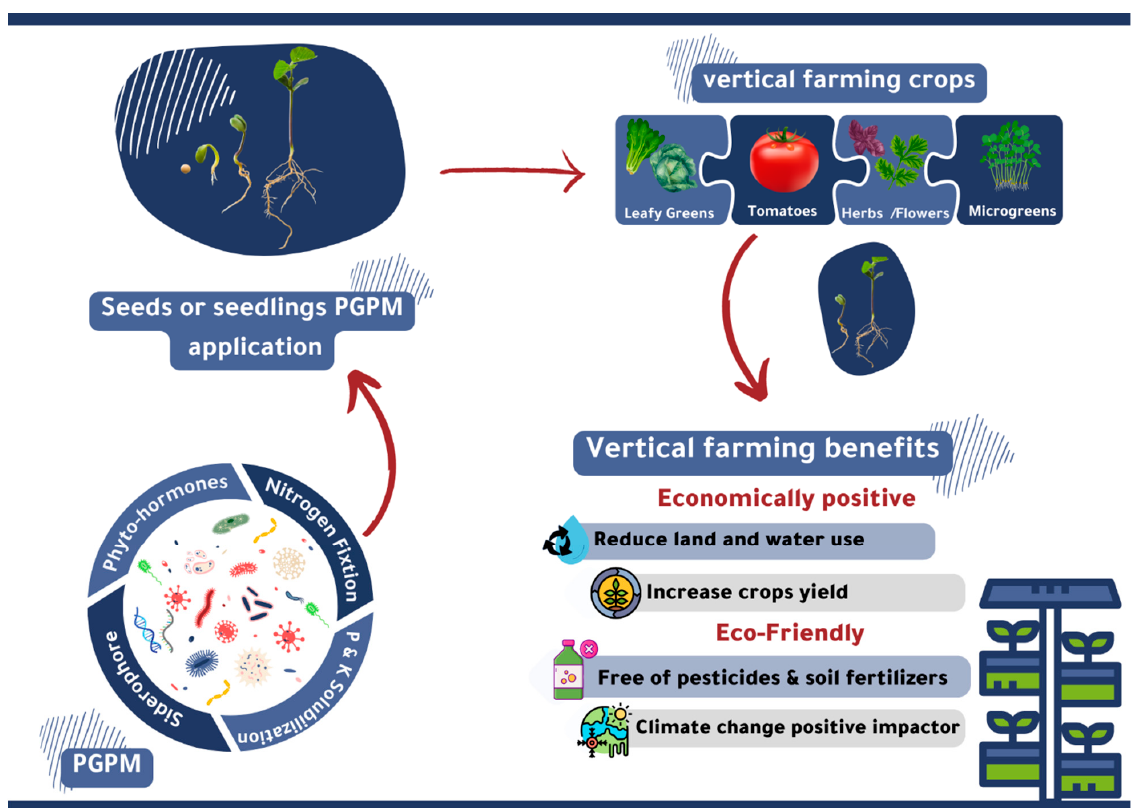
Figure 1. The types of plants used and the economic and environmental feasibility of growth-pro- moting microorganisms in hydroponics and vertical farming. promoting microorganisms in hydroponics and vertical